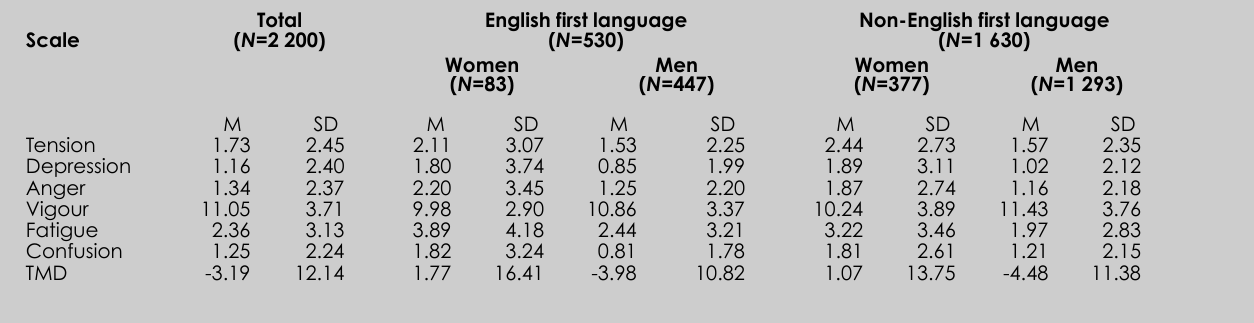
Table IV. Descriptive statistics of scores on the BRUMS grouped by gender and language